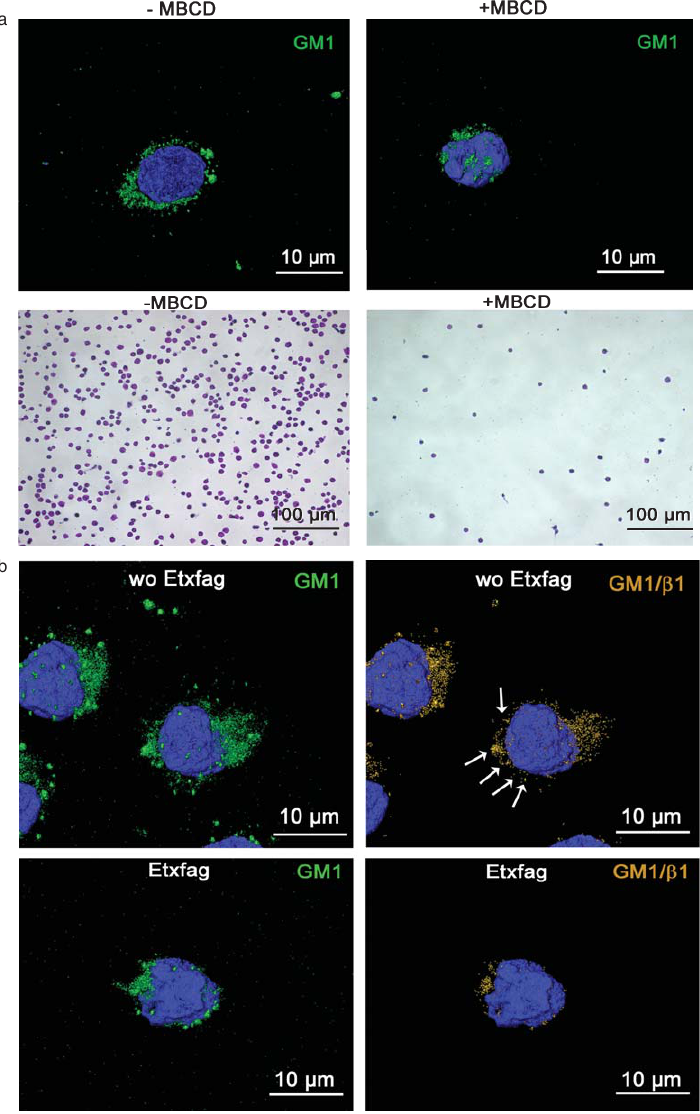
Fig. 8. Lipid raft integrity is necessary for L1210 cell adhesion to FN/V peptide. a ) L1210 cells treated or not with 10mM M (cid:1) CD for 1h were seeded to FN/V-coated glass culture slides in serum-free medium for 2h. Blue color represents nuclear staining with DAPI. L1210 cells were fixed with 4% paraformaldehyde then incubated with Alexa Flour 488-conjugated CTxB (green). Z projection ( Z =0.25 (cid:3) m) were realized by confocal microscopy using adequate settings for each fluorophore. Images were analysed with Amira ™ and are representative of three independent experiments (upper panels). L1210 cells treated or not with 10mM M (cid:1) CD for 1h were seeded to FN/V for 2h in a serum-free medium. Non-adherent cells were then discarded and adherent cells stained by violet crystal were visualized by microscopy (bottom panel). b ) L1210 cells treated or not with 1 × 10 − 7 M etxfag during 24h were seeded onto FN/V-coated glass culture slides in serum-free medium for 2h. Cells were fixed with 4% paraformaldehyde then incubated with a primary anti- (cid:1) 1 antibody (1:100) and labelled with a secondary antibody linked to Alexafluor 568 (data not shown). Cells were also incubated with Alexafluor 488-conjugated cholera toxin subunit B (CTxB). Blue color represents nuclear staining with DAPI. Surfacic reconstructions were realized from L1210 cells treated with (bottom panels) or without etxfag (upper panels). Surfacic reconstruction were proceeded from GM1 labelling (left row, upper and bottom panels) and from colocalization between GM1 and (cid:1) 1 (right row, upper and bottom panel) (gold). A representative image of three independent experiments is shown. c ) L1210 cells were treated or not with 1 × 10 − 7 M Etxfag during 24h then subjected to lipid extraction. GM1 ganglioside was used as a marker of lipid raft and its expression was assessed by using dot-blot CTxB staining followed by fluorescence spectroscopy